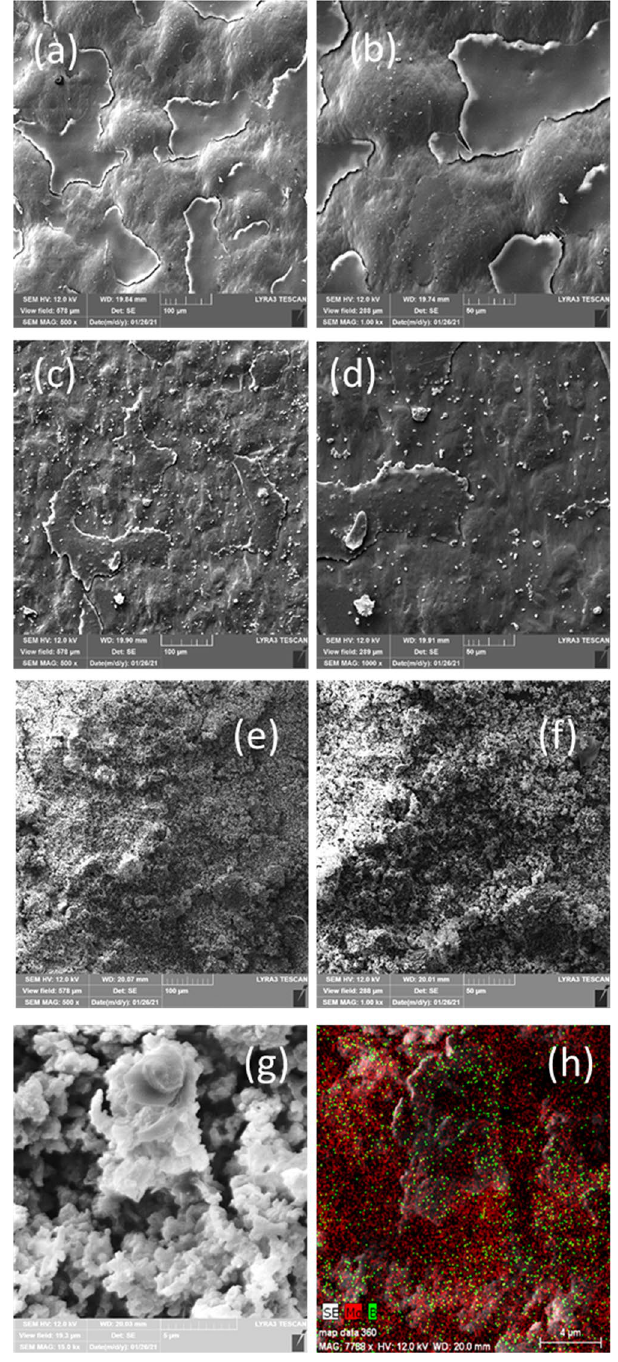
Figure 3. SEM images at two magnifications (× 500, × 1000) on MgB 2 -PVP films coated on plastic foil: ( a , b ) sample PVP foil ; ( c , d ) sample (MgB 2 -PVP) foil 0.25 ; ( e , f ) sample (MgB 2 -PVP) foil 3 . Secondary electron image from ( g ) presents a detail at high magnification (× 15,000) of sample (MgB 2 -PVP) foil 3 , while ( h ) is a red–green–blue image obtained by overlapping the elemental EDS maps of Mg and B measured on image from ( g